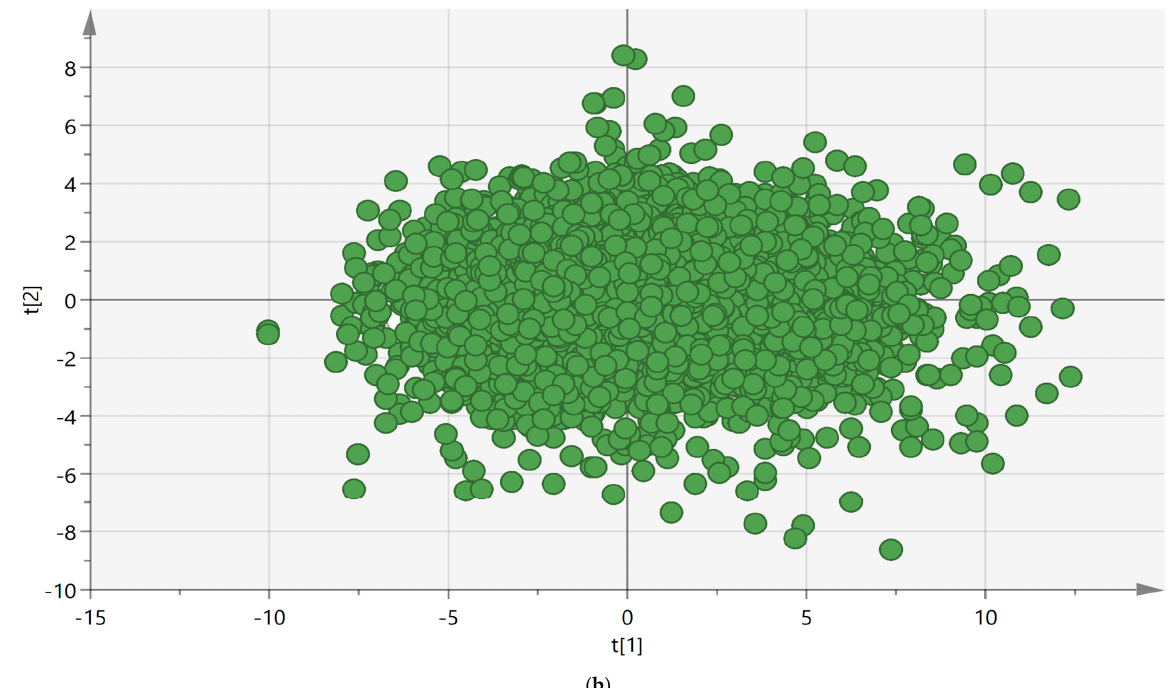
Figure 1. Loading plot of changes (pre-IMMRP vs. 12-month follow-up) in the 22 outcome variables—i.e., the relationships between the changes ( a ) and score plot (( b ); the relationships between the patients). diff = change in a certain variable; NRS-7days = Pain intensity as measured by a numeric rating scale for the previous seven days; HADS = Hospital Anxiety and Depression Scale; MPI = Multidimensional Pain Inventory; EQ-5D-index = The index of the European quality of life instrument; EQ-VAS = The European quality of life instrument thermometer-like scale; sf36 = The Short Form (36) Health Survey; For explanations of the subscale abbreviations, see Methods.